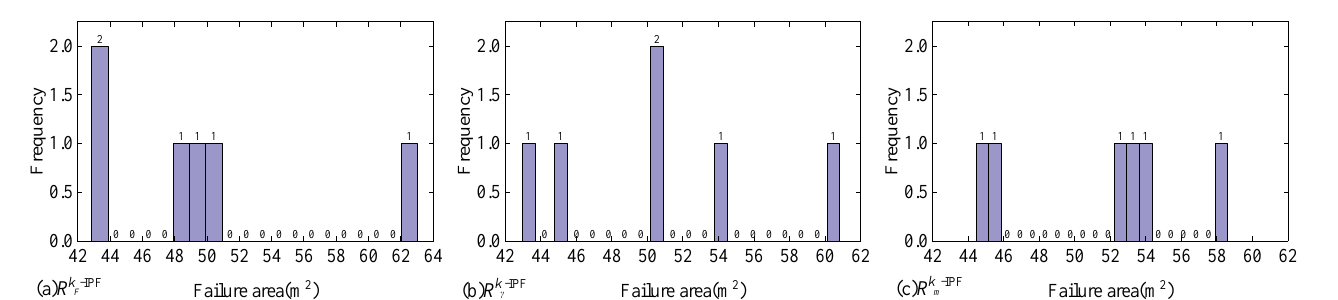
Figure 6. Homogeneous slope failure modes.